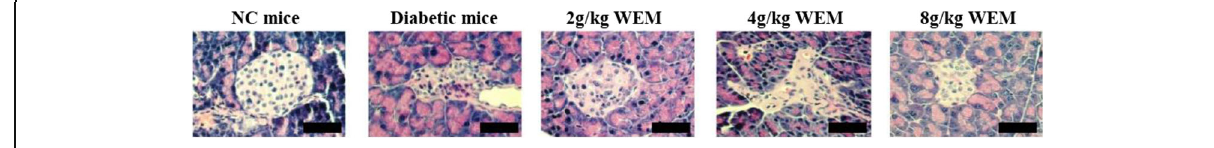
Fig. 11 H&E staining of pancreas in experimental mice at the 10-week administration. Scale bars, 200 μ